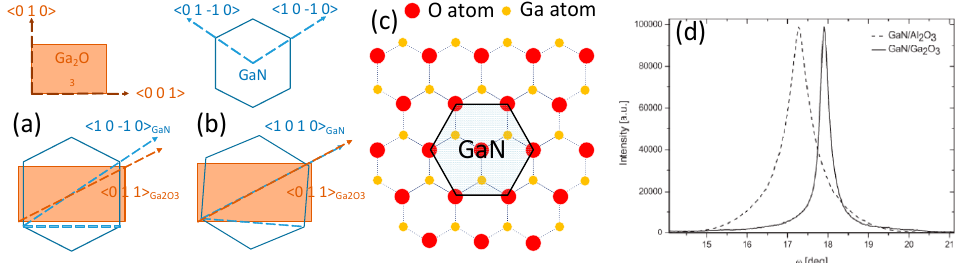
Figure 5. ( a ) Initial observation of epitaxial relationship between c -plane wurtzite GaN and (1 0 0) plane β -Ga 2 O 3 . ( b ) Refined model of epitaxial relationship between c -plane wurtzite GaN and (1 0 0) plane β -Ga 2 O 3 with a stressed and reoriented GaN at the interface, the lattice mismatch (LM) minimum of 2.6% is given at a 1° tilted angle with respect to case (a). ( c ) The projection of β -Ga 2 O 3 atomic structure perpendicular to the ( − 2 0 1) plane, showing the hexagonal-like arrangement of oxygen atoms. ( d ) Full width half maximum (FWHM) of HR-XRD rocking curves around the (0 0 0 2) Bragg reflection for GaN grown on Al 2 O 3 (2580 arcsec), and on β -Ga 2 O 3 (1020 arcsec). Reprinted with